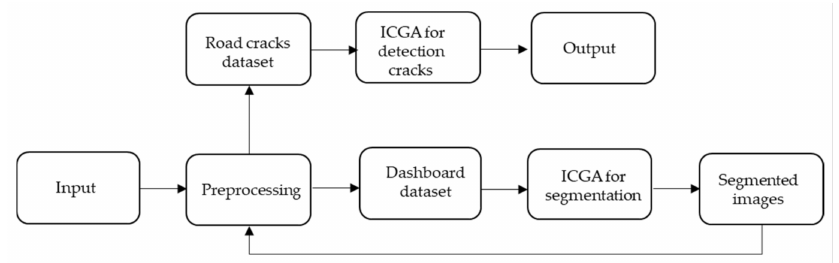
Figure 5. Implementation scheme of our multi-level